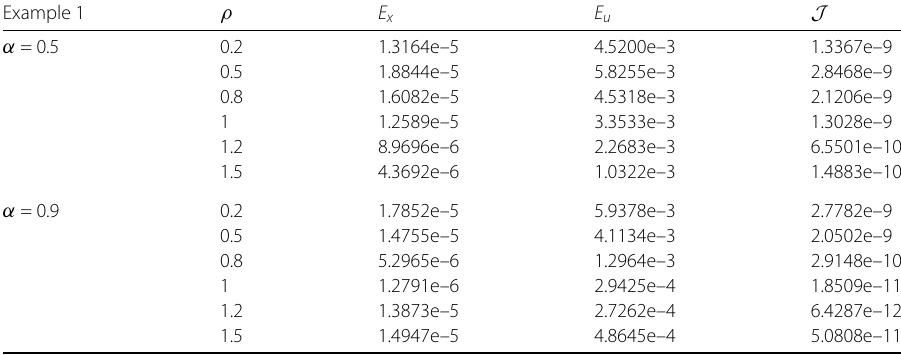
Table 5 The values of E x and E u for x ( t ) and u ( t ), respectively, at distinct choices of N N E